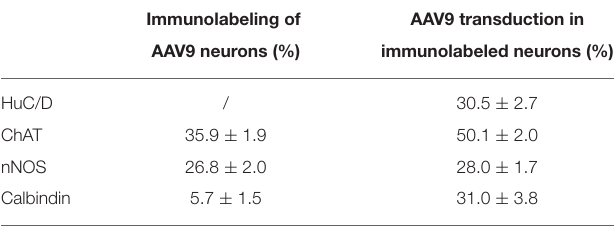
TABLE 3 | Percentage of neurons transduced by iv AAV9 (of HuC/D immunolabeled neurons), and percentage of AAV9-transduced neurons immunolabeled by selective neurotransmitter